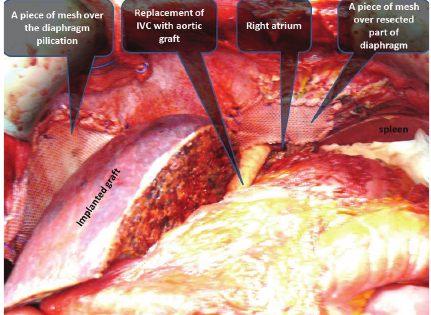
Figure 5: Final view after implantation. Diaphragm plication with mesh is seen.